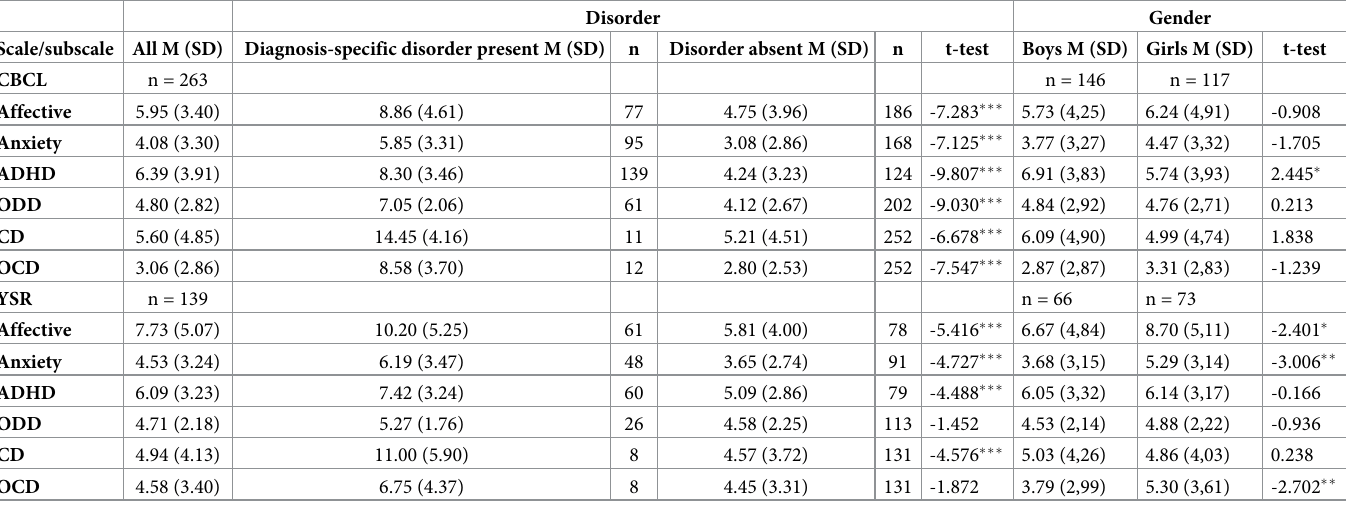
Table 2. Means, standard deviations, and independent t-test as per diagnostic group for CBCL and YSR and boys and girls.